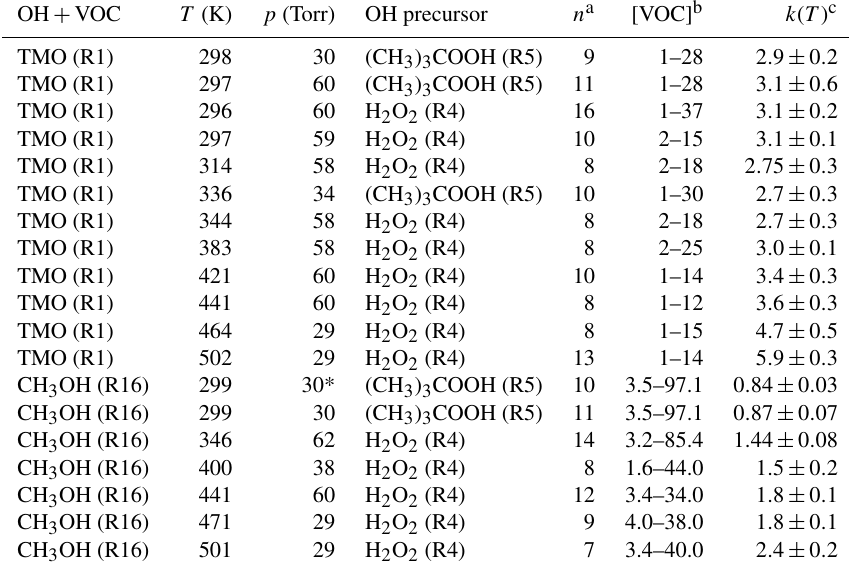
Table 2. Absolute k 1 ( T ) for OH + TMO and k 16 ( T ) for OH + CH 3 OH determined via PLP–LIF in this work.